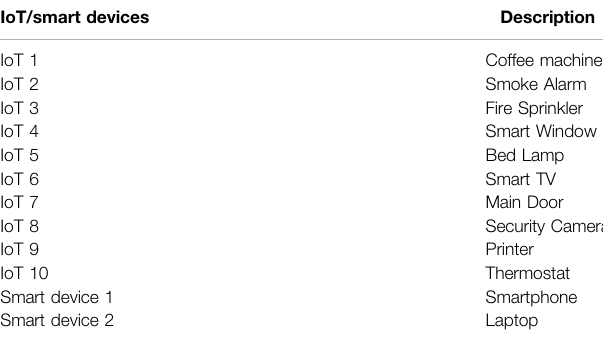
TABLE 1 | List of IoT/Smart devices used in the